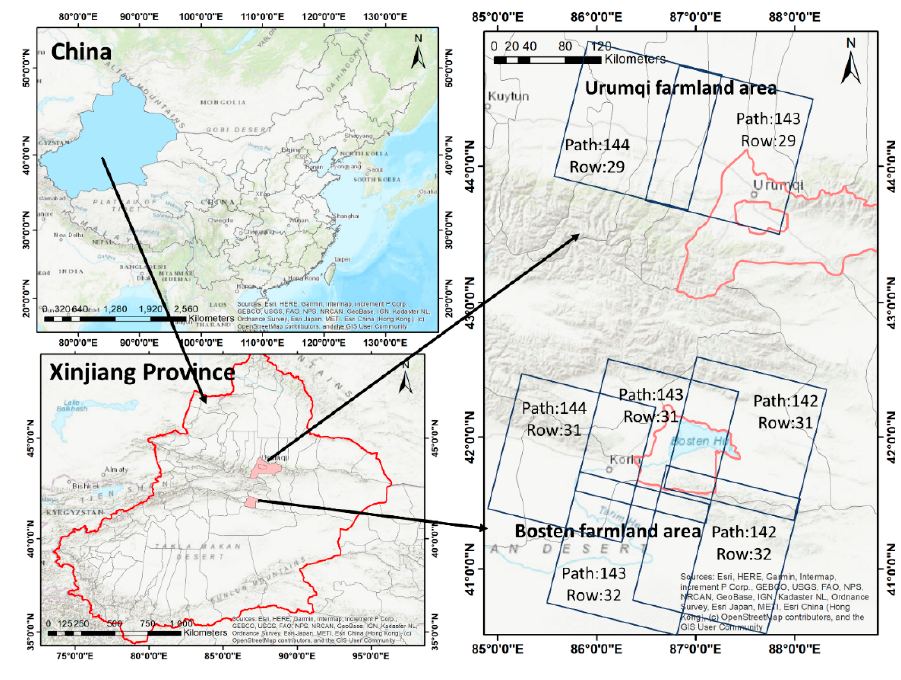
Figure 1. The study area. Table 2. Data list of Landsat 5 top of atmosphere (TOA) products used in this study.